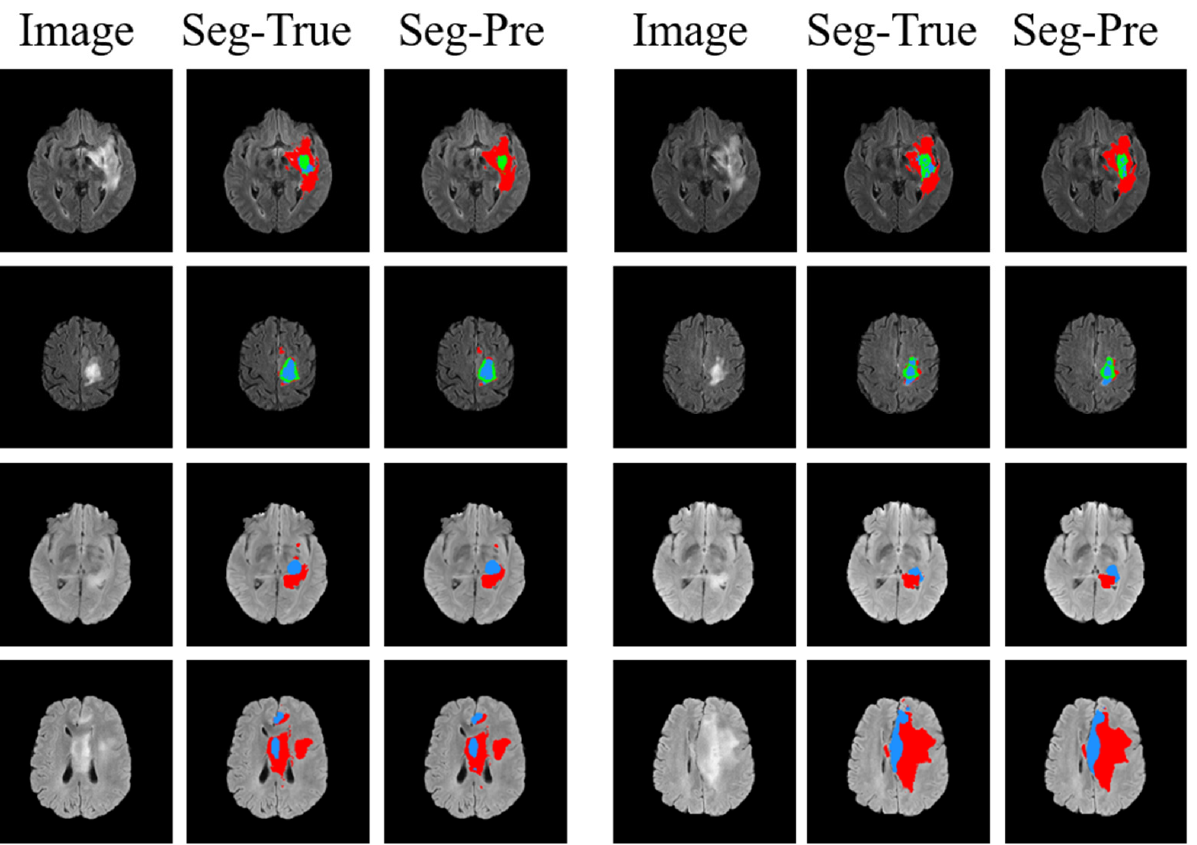
Figure 4. Comparison of brain tumor segmentation outputs and GT.